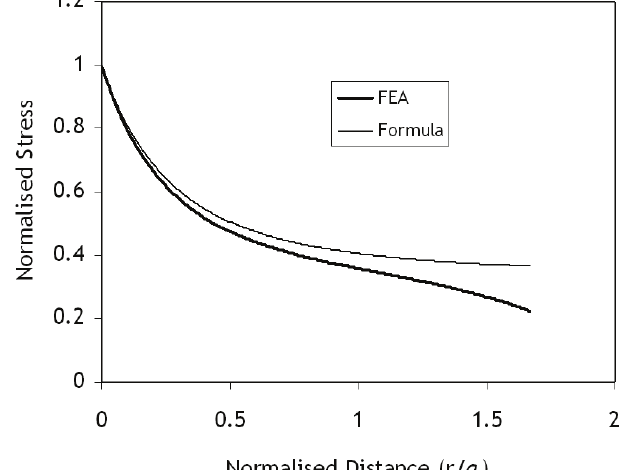
Figure 4: Stress as a function of distance from notch root, calculated using the approximate formula (Eq. 5), compared to an accurate result obtained from FEA.